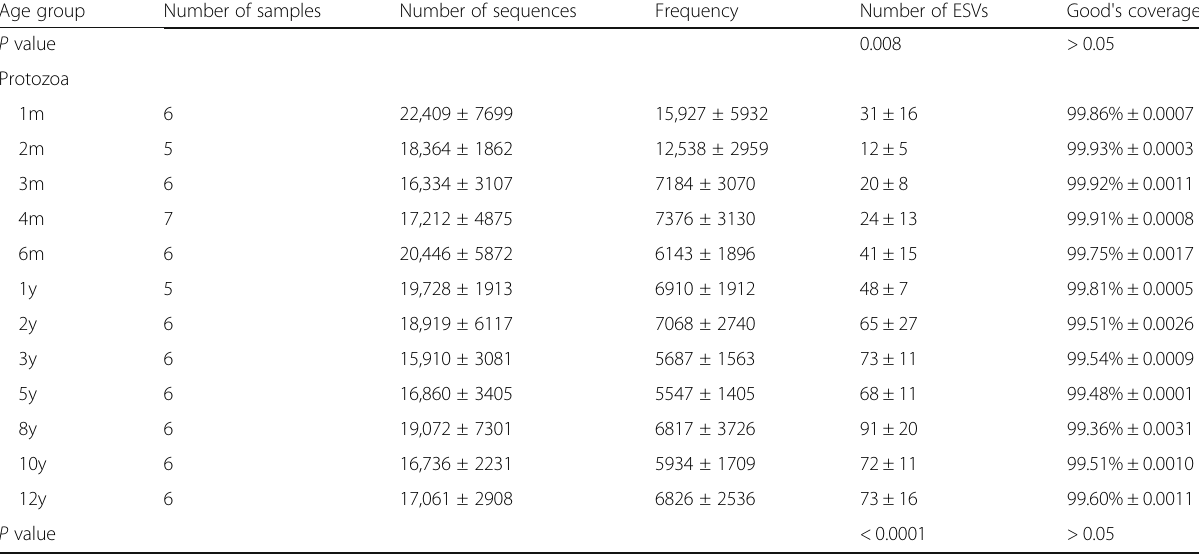
Table 1 Sample information and sequencing statistics obtained using the DADA2 algorithm in QIIME2 (Continued) Age group